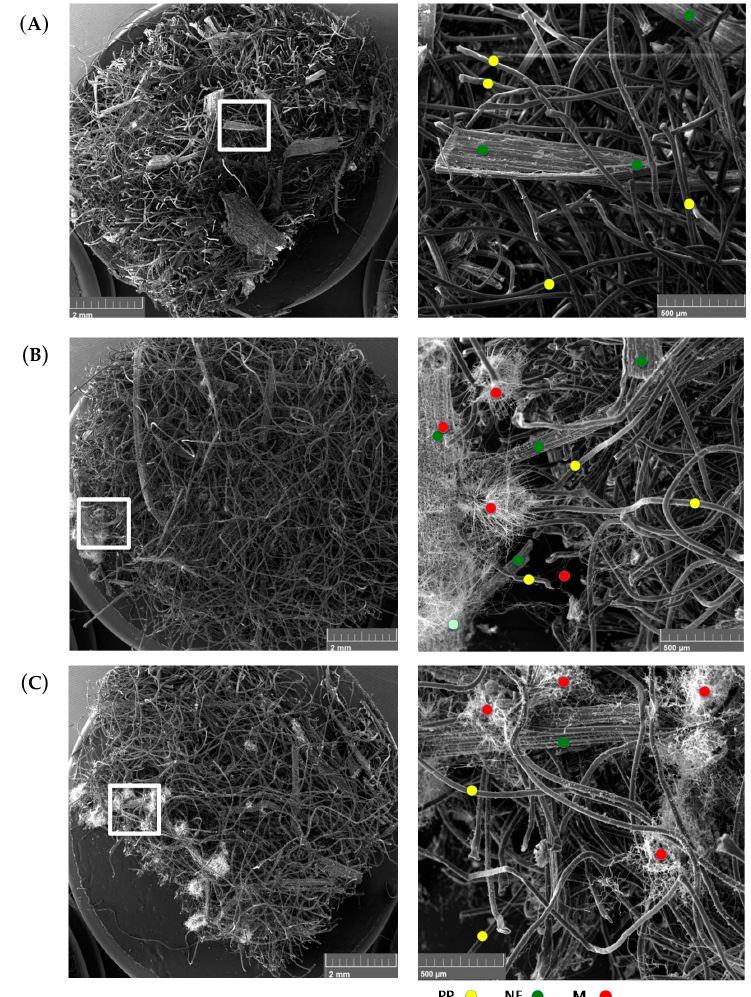
Figure 4. Scanning electronic microscope (SEM) micrographs with low (left) and high (right) magnification for the hemp-PP dry mats at t 28 , under different exposure conditions. The conditions included ( A ) no water-no fungi, ( B ) yes water-no fungi, and ( C ) yes water-yes fungi. It is noticed that fungi grew on the natural fibers under wet ambient conditions, i.e., without the addition of any fungi, as in ( B ), indicating that there have been omnipresent fungal species in the material prior to its processing. Notice the extent and distribution of fungal growth in ( C ). Yellow, green and red circles indicate the presence of sample PP fibers, natural fibers, and mycelium fungus.